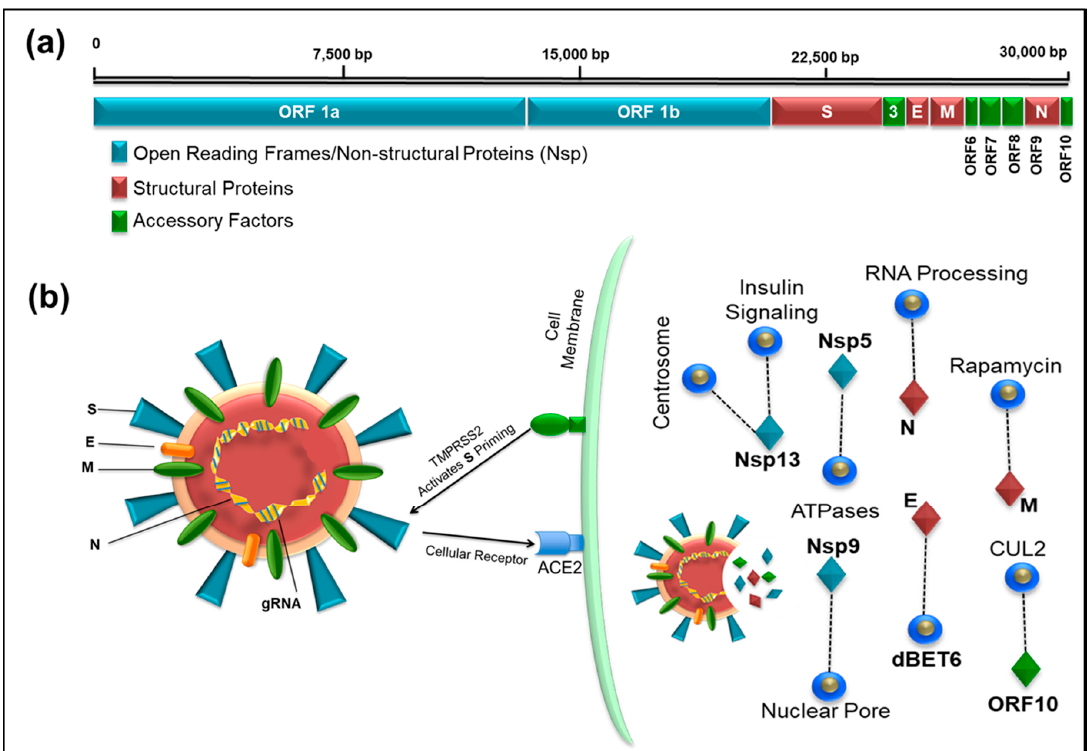
Figure 1. ( a ) Illustration of the full-length genome of SARS-CoV-2 showing the location of open reading frames 1a and 1b encoding the Non-structural proteins, Nsp (blue), structural proteins (brown), and accessory factors (green). The numbers on top refer to the genomic RNA; ( b ) schematic representation of the SARS-CoV-2 virus particle and its interaction with its host cellular receptor, ACE2. The infection pathway is shown where after docking of the virus particle on cell surface, the TMPRRSS2 cellular protease activates the viral protein S allowing entry of SARS-CoV-2 into human cells. The protein coded by the viral genes and some of the notable interactions (dashed line) with other host proteins are shown that can potentially be targeted by drugs (blue circles).